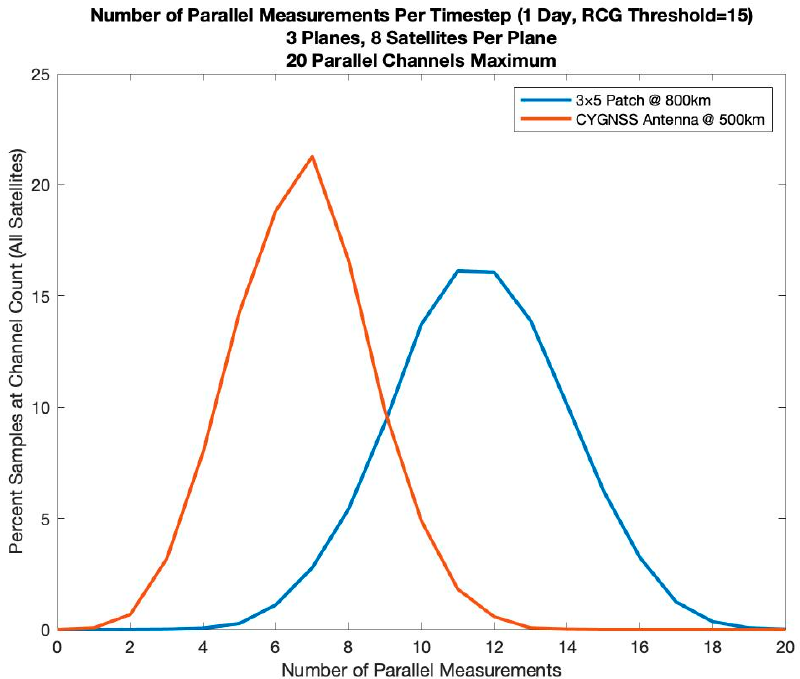
Figure 8. Parallel Measurement Comparison between antenna patterns at their corresponding altitudes over 24 h using a 3-Plane constellation with each plane at 30°, 60°, and 90° inclination, 20 Parallel Measurements Maximum per sampling, and an RCG Threshold of 15.